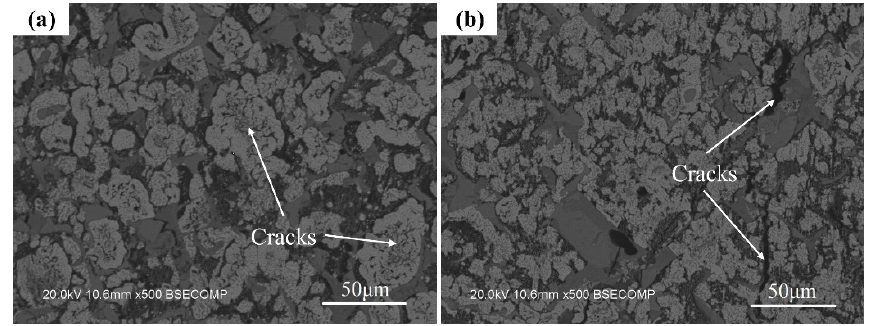
Figure 8. Microstructure after low temperature reduction ( a ) 2.7% MgO; ( b ) 2.9% MgO.